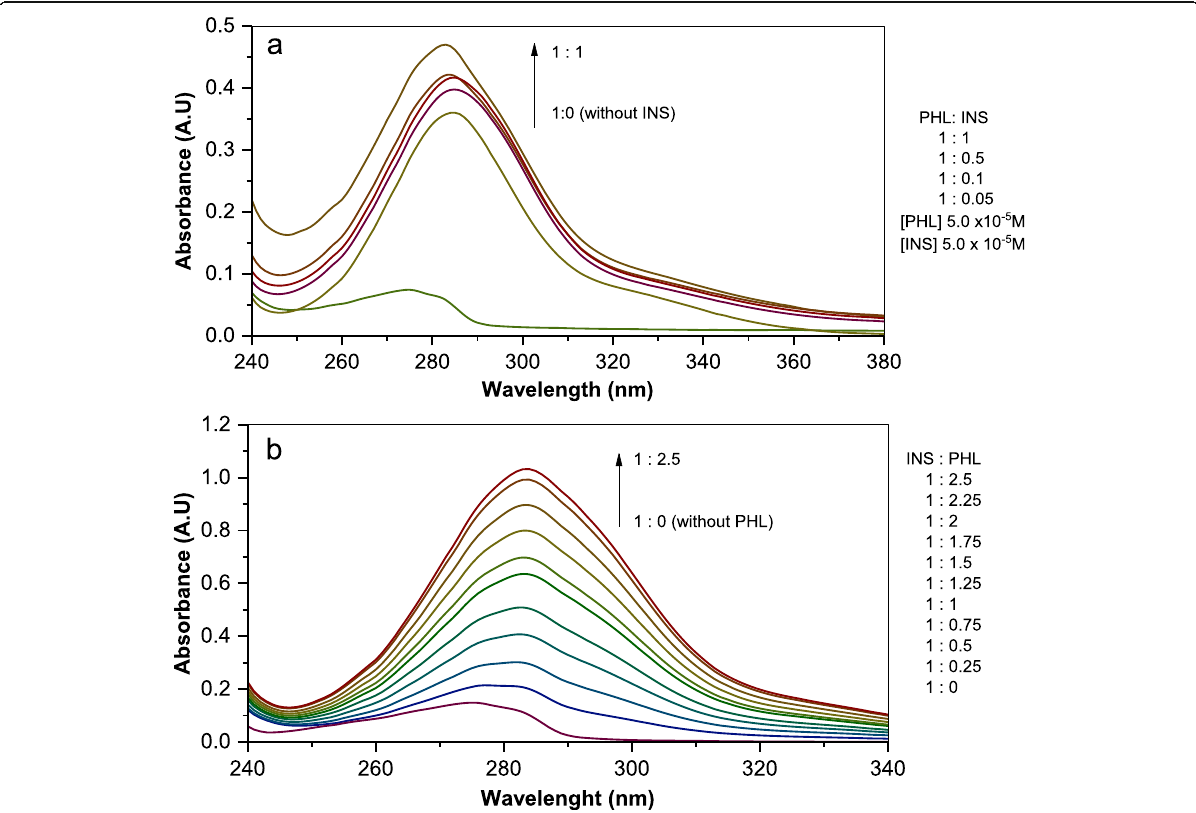
Fig. 1 Absorption Spectrum of PHL after variation of INS ( a ), INS after variation of PHL ( b